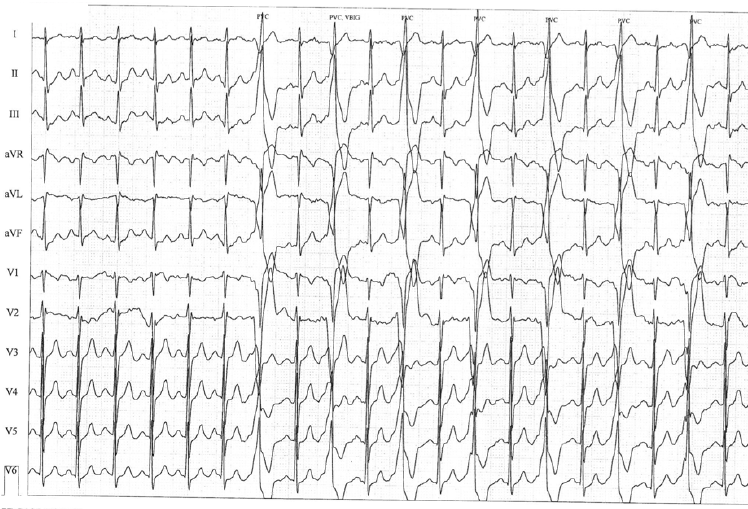
Figure 1. Appearance of ventricular bigeminy during exercise test, which was preceded by isolated premature ventricular contractions.